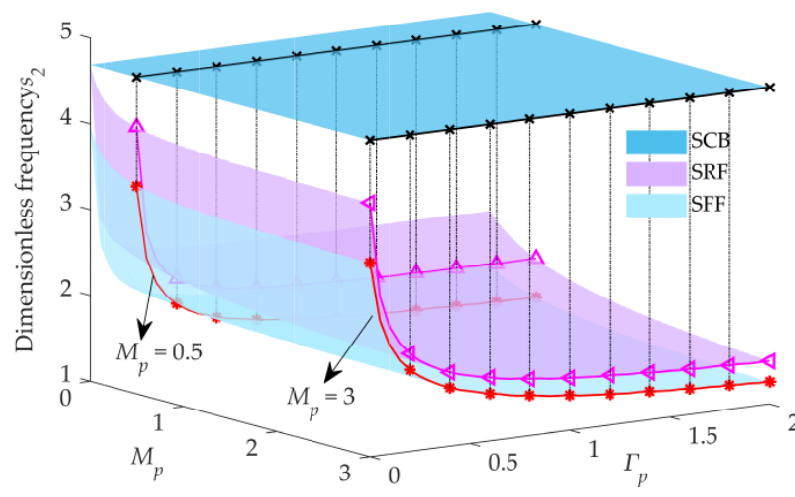
Figure 7. 3D surfaces of the second frequency versus M p and Γ p ( k m = 0.5). Therefore, due to joint flexibility, the frequencies of SFF are lower than those of SCB and SRF. Moreover, if the stiffness of the joint is large and the moment of inertia in the tip load is small, the differences in the lower-order frequencies among SCB, SRF, and SFF are not significant. It can be inferred that in this case, whichever mode is selected as the assumed mode has no obvious difference in the model. However, in the opposite case, the differences in lower-order frequencies among SCB, SRF, and SFF are significant. Thus, it is necessary to be careful in choosing the assumed mode. Hence, the corresponding dynamic responses are studied in the next section.